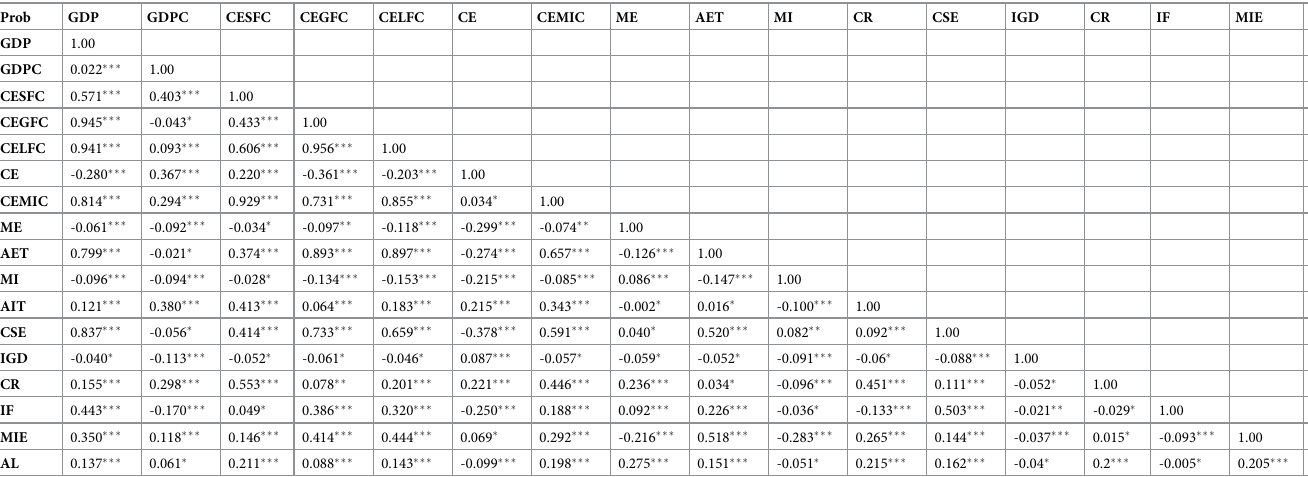
Table 13. Indicate Vector Error Correction (VEC), with cointegration restrictions B (1,1) = 1 and the convergence attained after 1 iteration with t-statistics and Standard error Fig 6. The